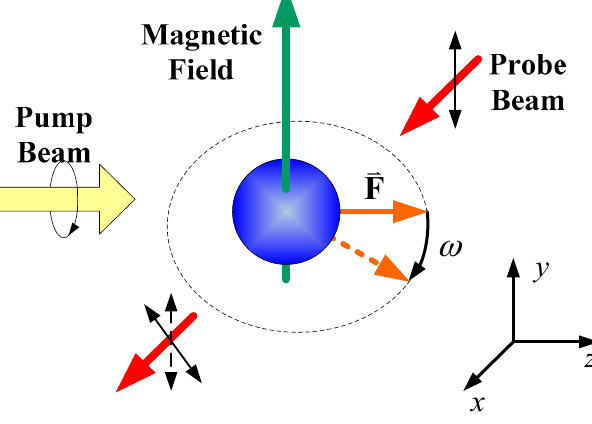
Figure 1. (Principle of the SERF atomic spin magnetometer. Figure 1. Principle of the SERF atomic spin